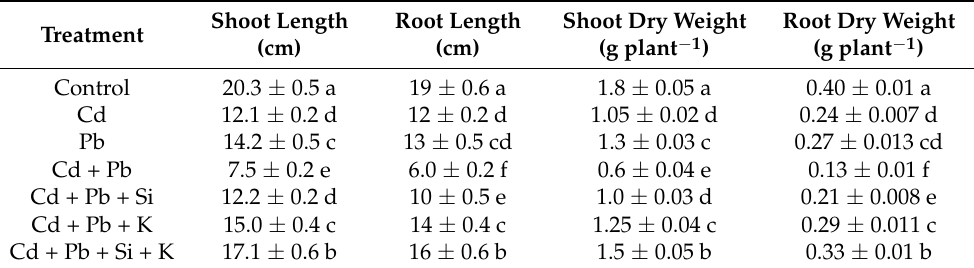
Table 1. Growth attributes of quinoa plants under Cd and Pb treatments with or without supplemen- tation with Si and K.